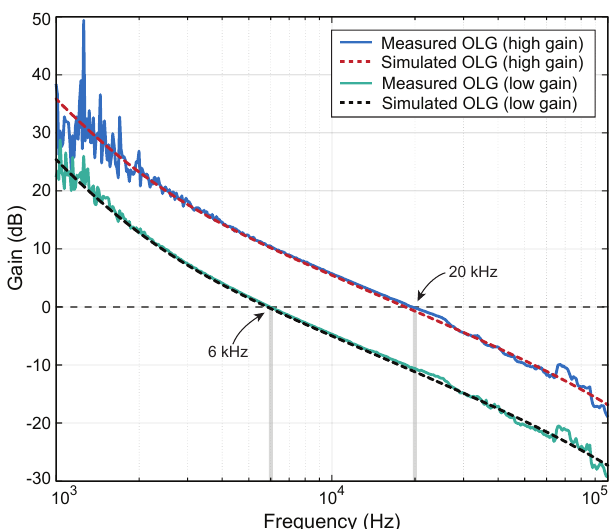
Figure 10. Measured (solid) and simulated (dashed) open-loop gain of the offset phase-locked OPA’s control system for high and low gains.